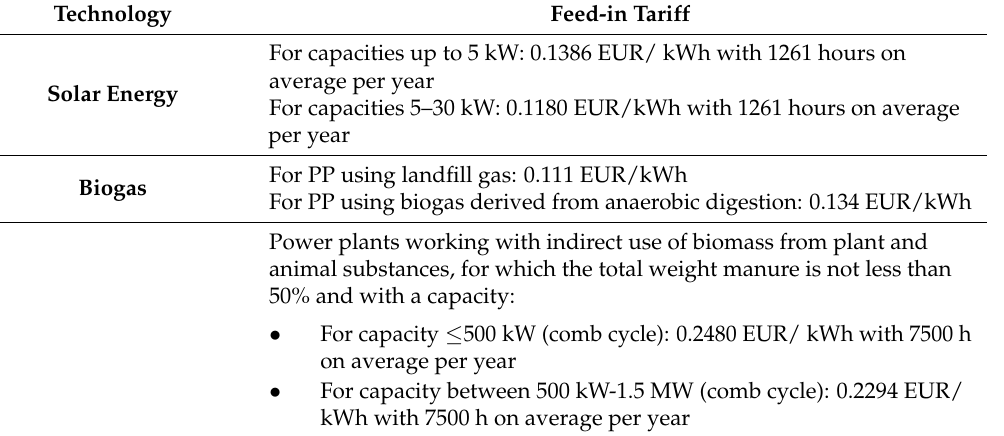
Table 6. Feed-in tariffs for renewable energy technologies with installed capacity up or equal to 10 kW. Source: created by authors based on